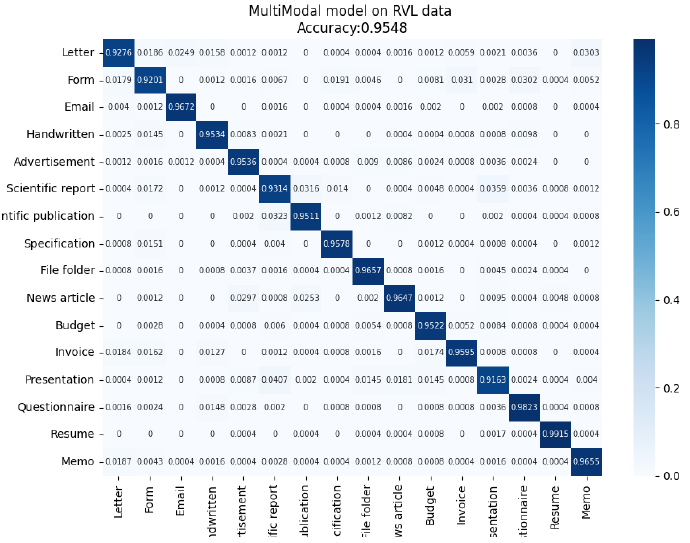
Figure 10. The figure depicts the confusion matrix of the model on RVL-CDIP test